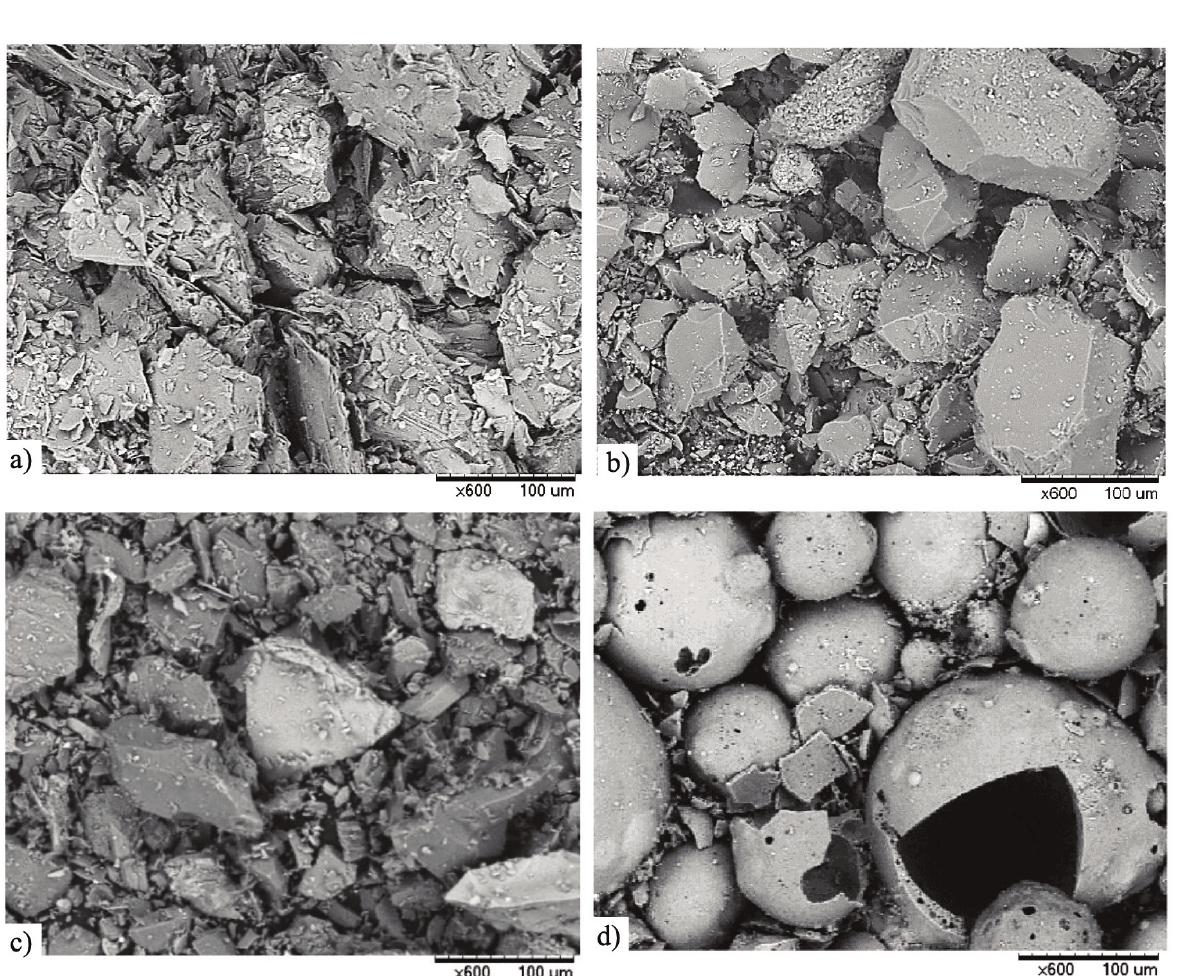
Fig. 2. Filler materials: a – granite sand, b – quartz sand, c – polarstone sand, d – fly ash